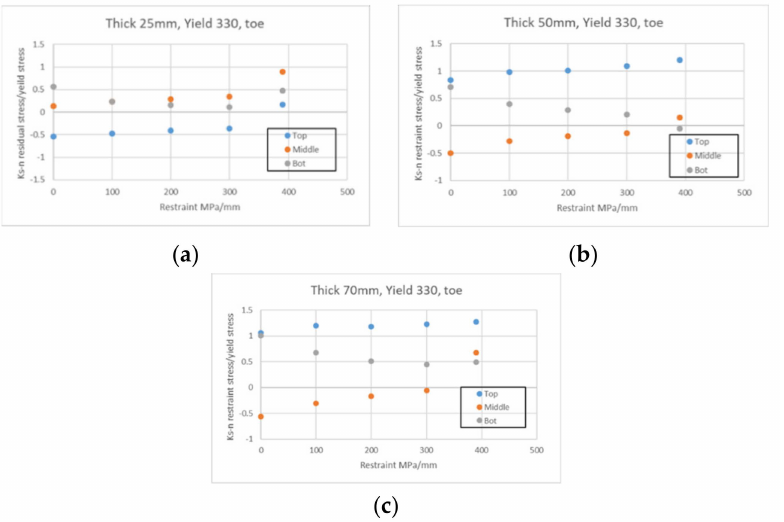
Figure 16. Ratio of K s –n residual stress/yield stress according to the thickness at a yield stress of 330 MPa: ( a ) thickness of 25 mm; ( b ) thickness of 50 mm; and ( c ) thickness of 70